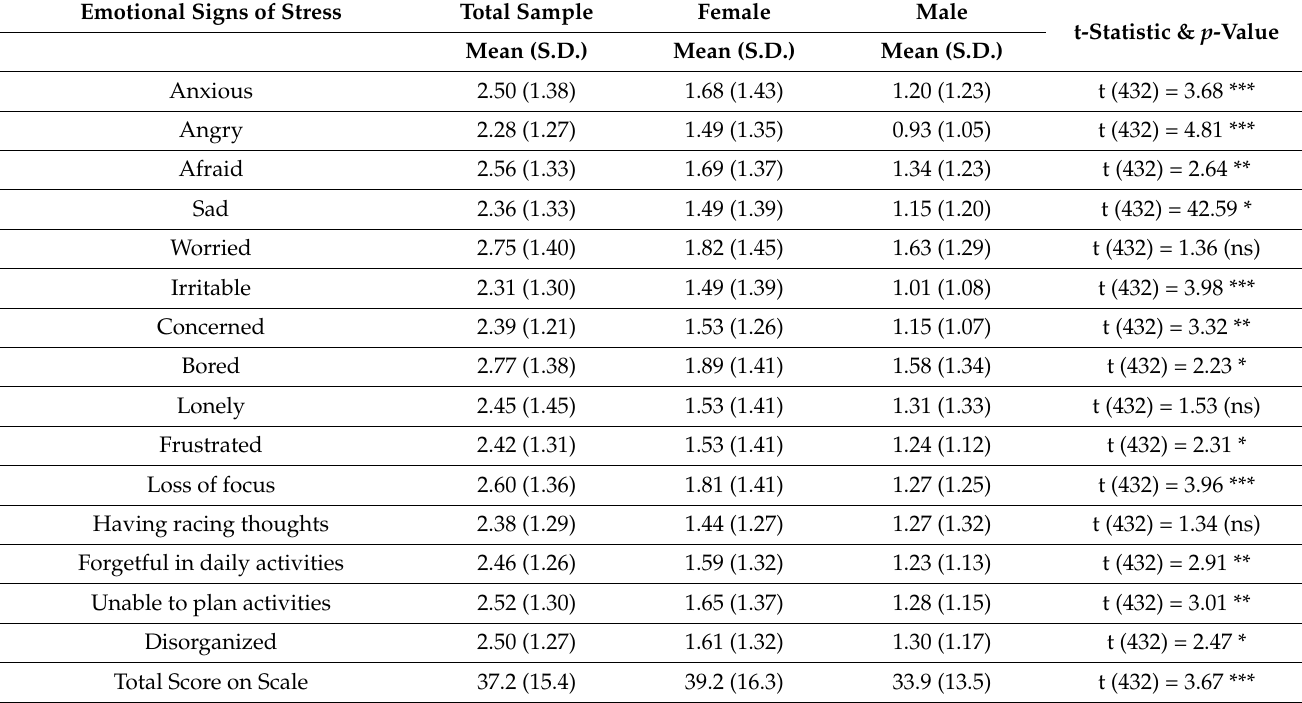
Table 2. Emotional signs and symptoms of stress in the total sample and across genders (n = 434). Emotional Signs of Stress Total